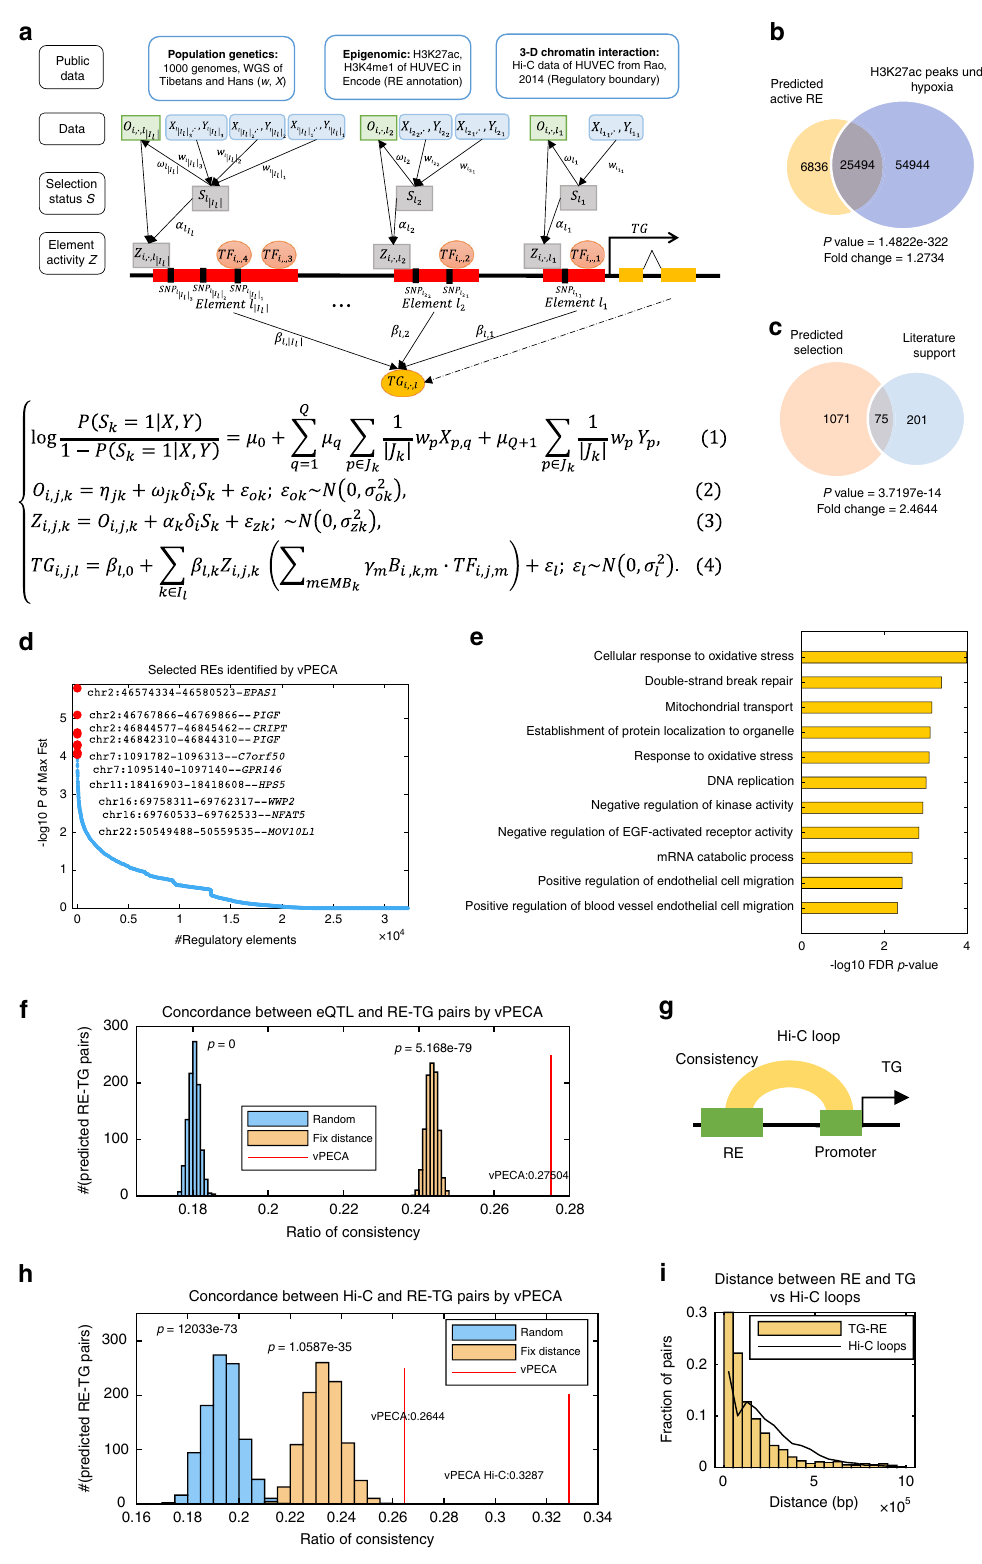
fi ve active REs (Supplementary Fig. 5a). In addition, we use ω ≠ 0 to select those REs under selection with differential accessibility in local time points. Target genes are enriched for functions in stress response and metabolic process etc. (Supplementary Fig.